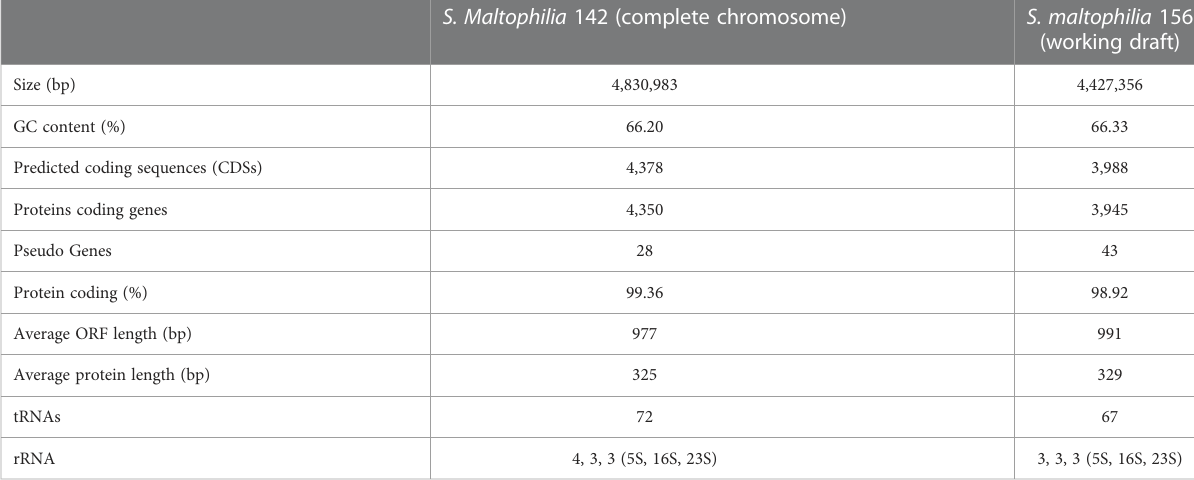
TABLE 2 General features of the S. maltophilia isolates 142 and 156 genomes.